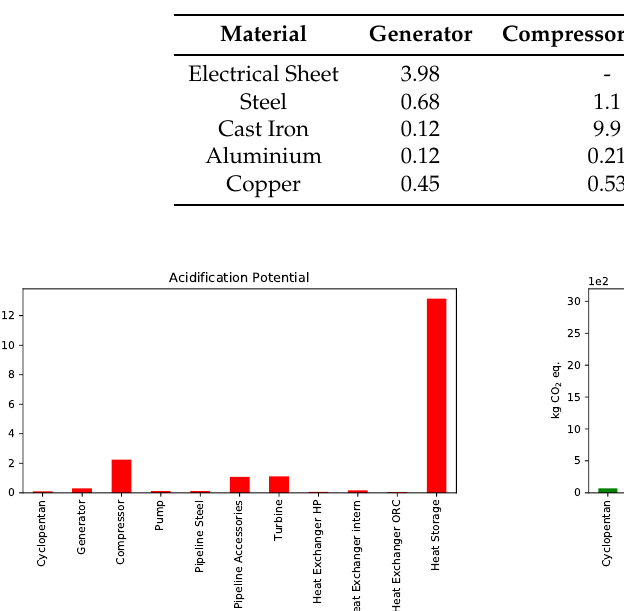
Table 8. Used physical composition for a generator, compressor and pump in kg pro kW.